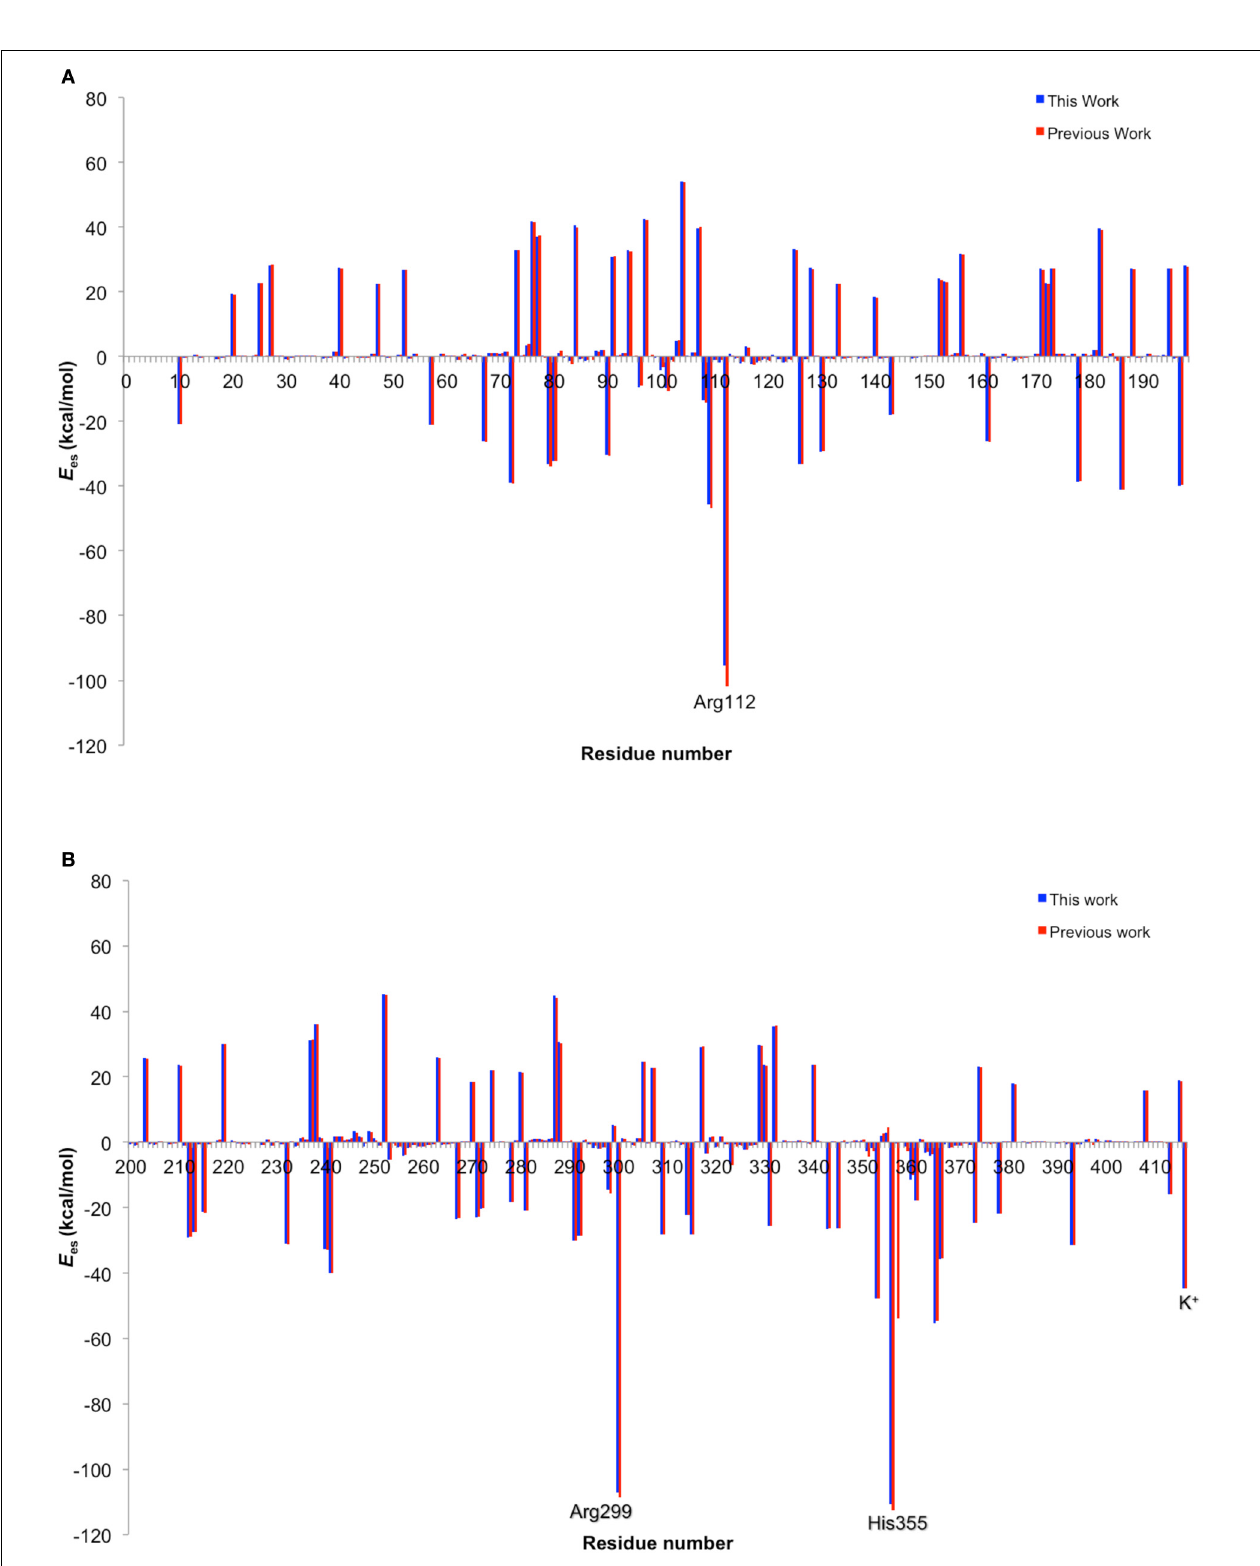
FIGURE 11 | Comparison of electrostatic energy contributions from amino acid residues 10-199 (A) and 200-414 and K + (#415) (B), obtained in this work with method 1 (blue) and in a previous work (red). Reprinted from Thellamurege and Hirao (2014) with permission from the American Chemical Society.